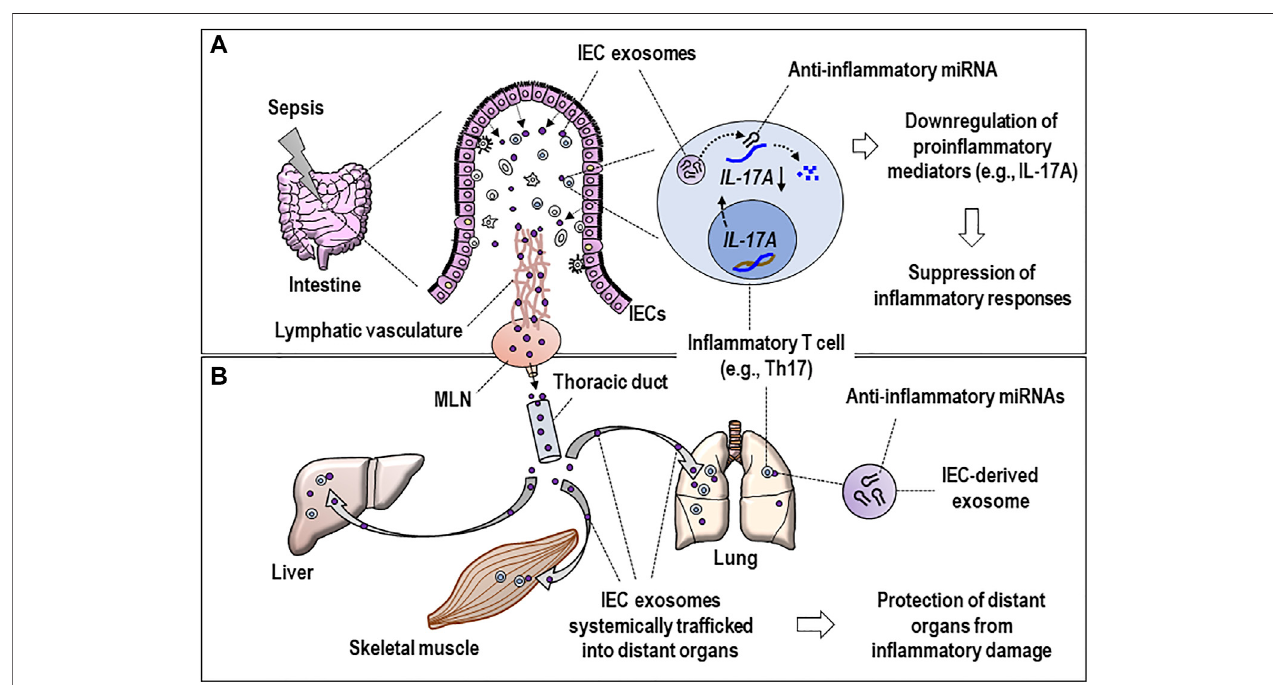
FIGURE 2 | Hypothetical model for the dynamic activity of basolaterally released septic IEC exosomes in regulating in fl ammatory responses at local and distant tissues. (A) IECexosomesreachin fl ammatoryTh17cellsinthelaminapropriaofin fl amedintestinesanddelivermiRNAs(e.g.,miR-22ormiR-126a,seetext)tosuppress the IL-17A expression, proposing the miRNA-induced suppression of in fl ammatory responses that occurred at local tissues. (B) IEC exosomes possessing regulatory miRNAs are assumed to undergo systemic traf fi c via the lymphatic vasculature, MLNs, and thoracic duct and subsequently reach distant organs (e.g., lung, liver, etc.) to further alter functions of in fl ammatory T cells in multiple organs by the same method of transferring the miRNAs. Eventually, it can be hypothesized that IEC- derived exosomes may be involved in protecting the tissues from in fl ammatory damage. IEC, intestinal epithelial cell; MLN, mesenteric lymph node; IL-17A, interleukin 17A; Th17, T helper